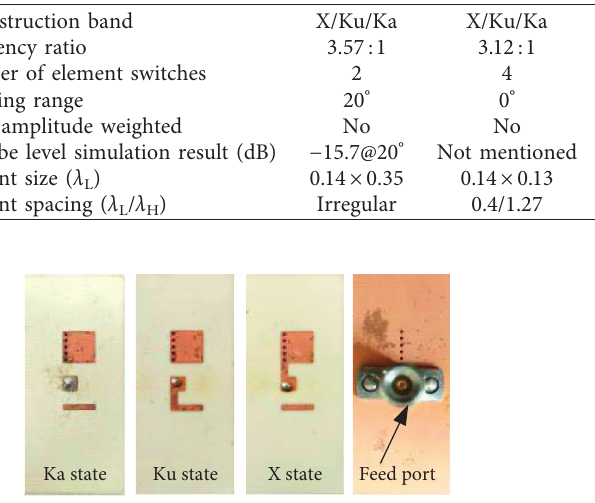
Figure 16: The fabricated FRA prototypes.